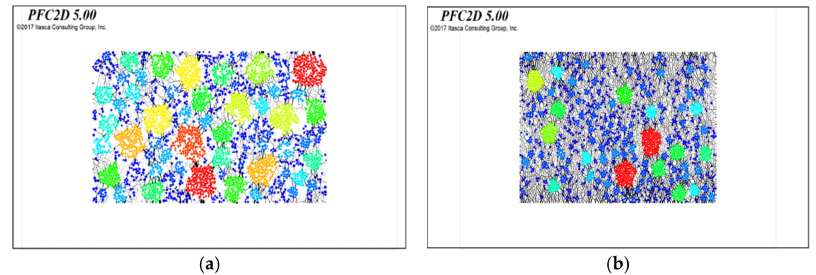
Figure 7. The force chain diagram of OGFC and AC under loading. ( a ) The force chain diagram of OGFC; ( b ) the force chain diagram of AC.